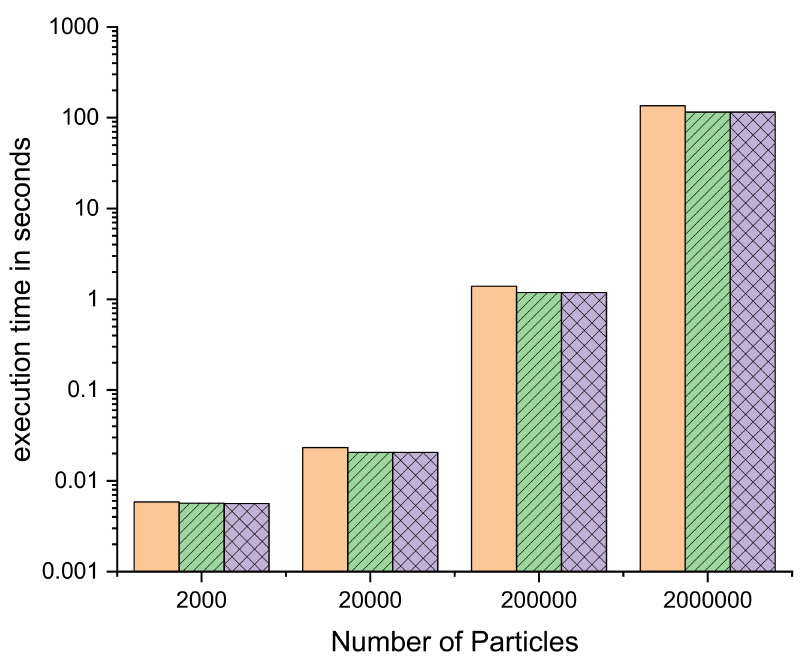
Figure 7. Execution time as a function of number of particles at different frequencies: 4 × 36_214 MHz. orange full column, 4 × 36_250 MHz. green dashed column and 4 × 30_300 MHz. lilac crossed